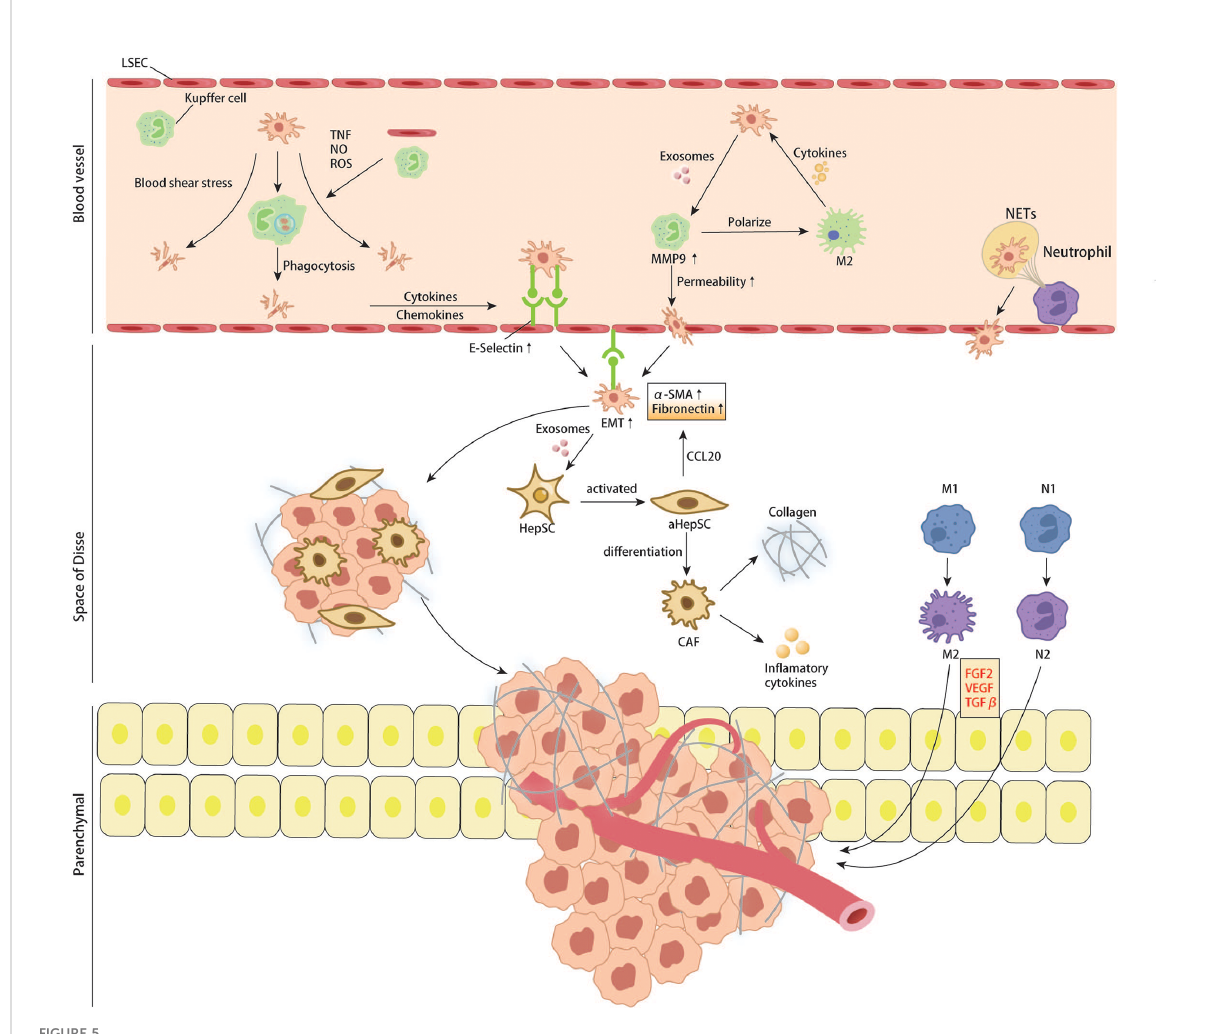
FIGURE 5 CRC cells interact with resident cells of liver and recruited immune cells in liver sinus, space of Disse and liver